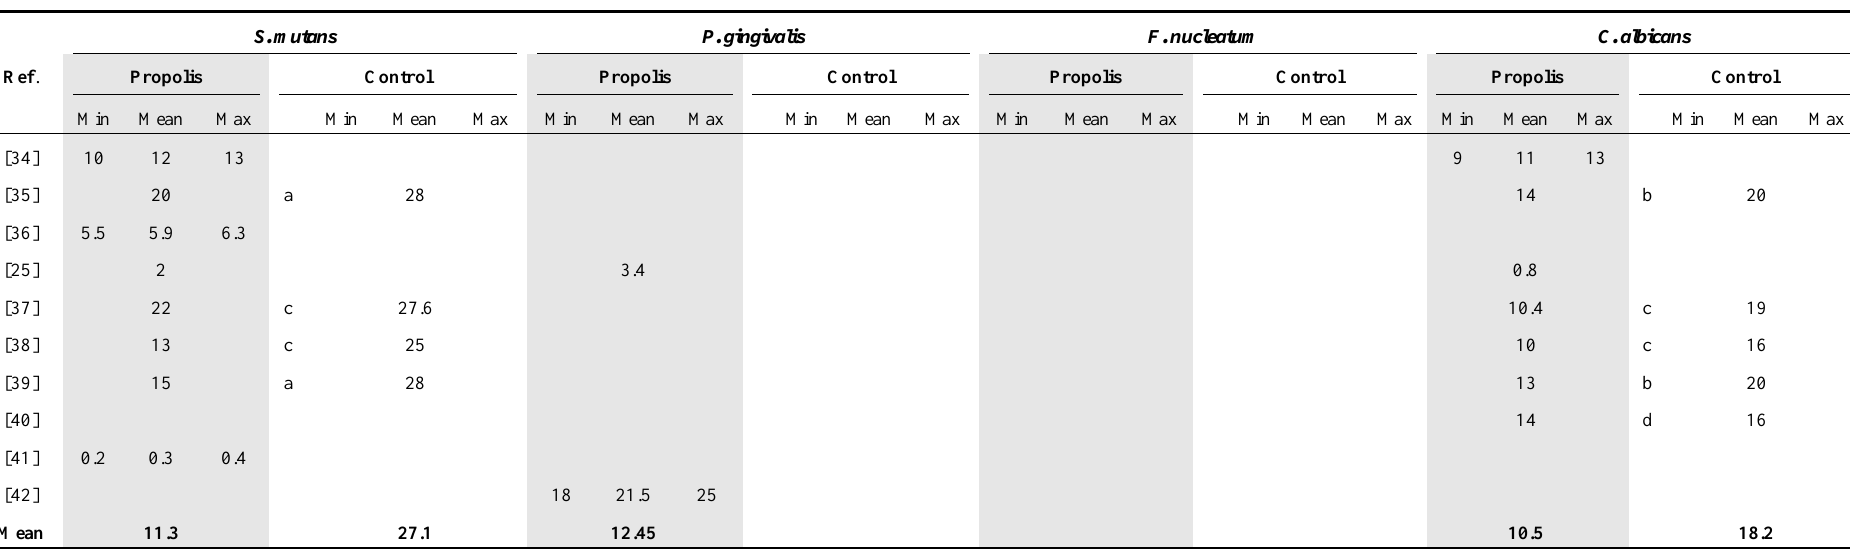
Table 1. Results of the agar diffusion tests (inhibition zones in mm) to evaluate propolis and control compounds (indicated with different superscript